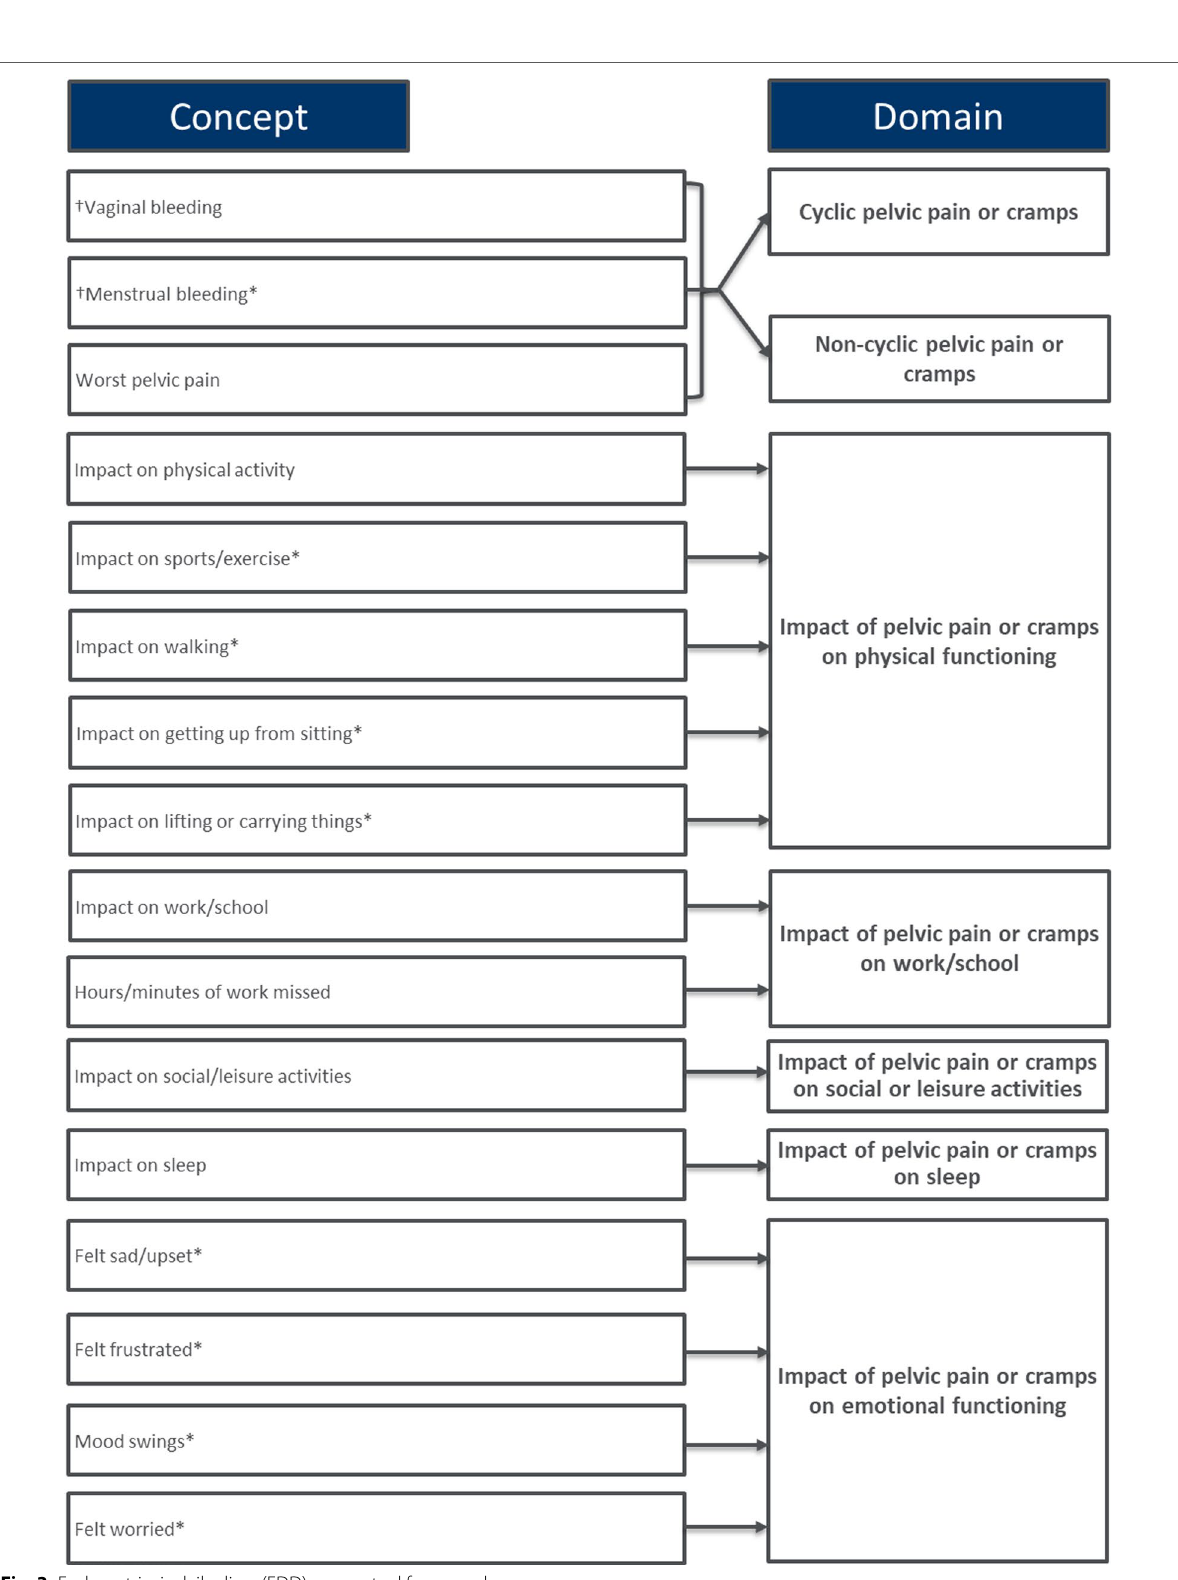
Fig. 3 Endometriosis daily diary (EDD) conceptual